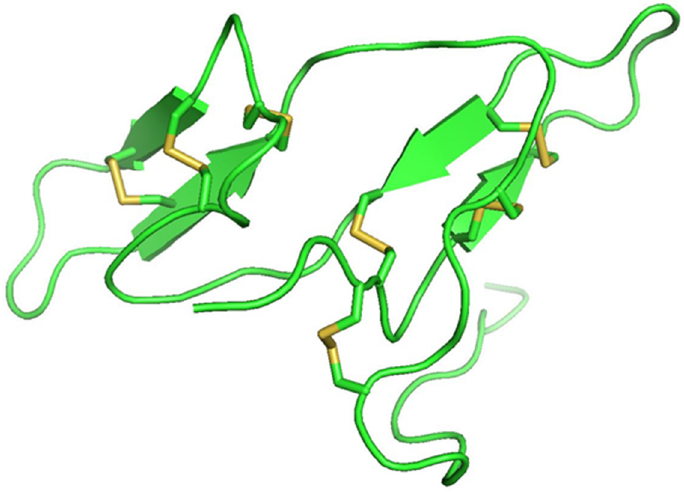
Figure 3. Bowman–Birk inhibitor from pea (PDB ID: 1pbi) showing seven disulfide bonds (yel- low).